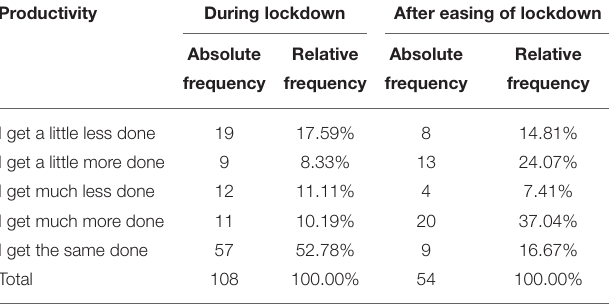
TABLE 9 | Cross-tabulation for e-workers